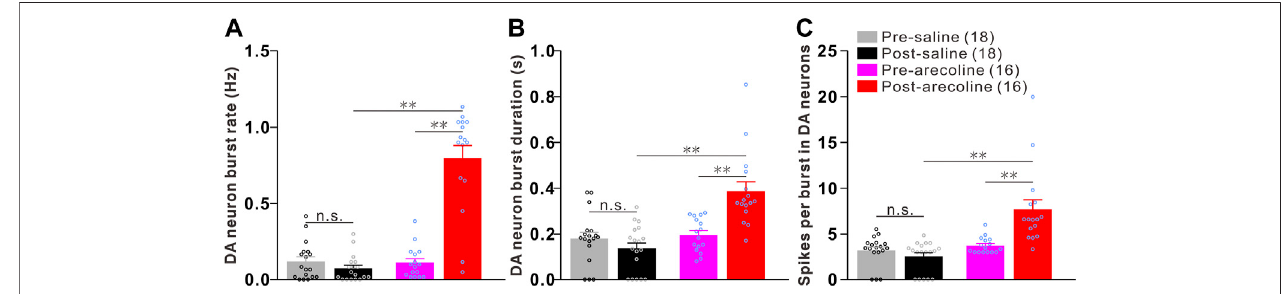
FIGURE 2 | Arecoline induces burst fi rings in VTA dopaminergic neurons. (A – C) Histograms of the burst parameters in dopaminergic neurons before and after saline/arecoline treatments. (A) Burst rate, (B) the burst duration, and (C) the number of spikes per bursts. The numbers presented in the parentheses denote the number of neurons measured, while the overlaid dots are the individual data points. DA neuron: dopaminergic neuron. ** p < 0.01; NS, not signi fi cant.